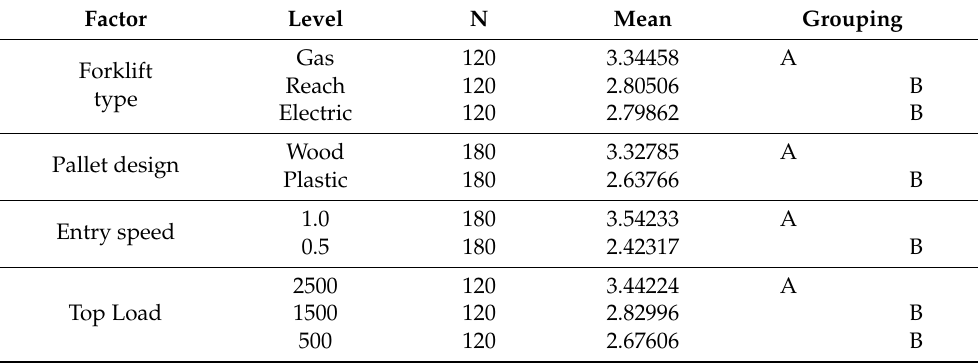
Table A1. Tukey Pairwise comparison for forklift acceleration response (Main